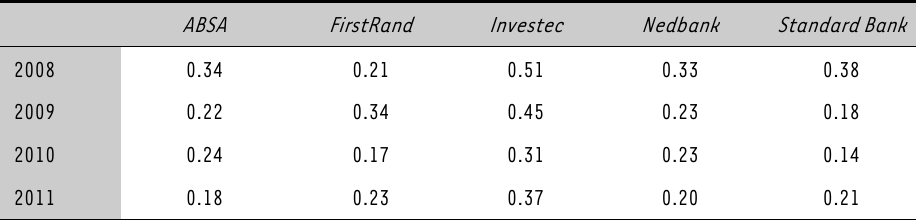
TABLE 12: Yearly cash flow yield ABSA FirstRand Investec